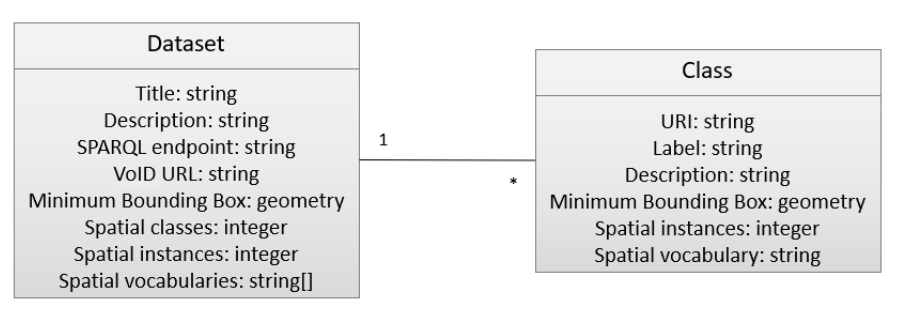
Figure 1. GeoLOD Catalog item metadata. A class may belong to 1 dataset and a dataset can contain many (*)